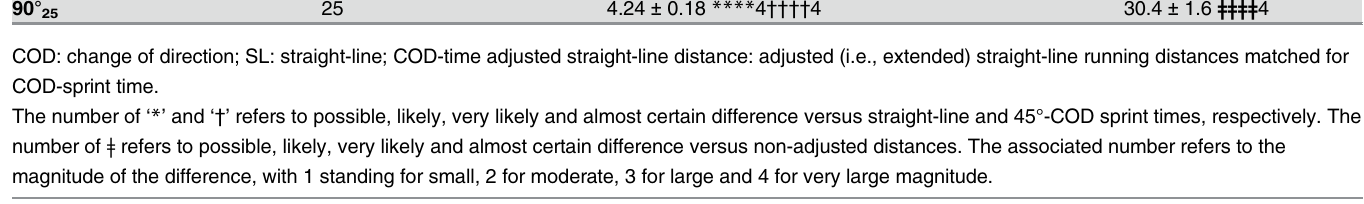
COD: change of direction; SL: straight-line; COD-time adjusted straight-line distance: adjusted (i.e., extended) straight-line running distances matched for COD-sprint time. The number of ‘ * ’ and ‘†’ refers to possible, likely, very likely and almost certain difference versus straight-line and 45°-COD sprint times, respectively. The number of ǂ refers to possible, likely, very likely and almost certain difference versus non-adjusted distances. The associated number refers to the magnitude of the difference, with 1 standing for small, 2 for moderate, 3 for large and 4 for very large